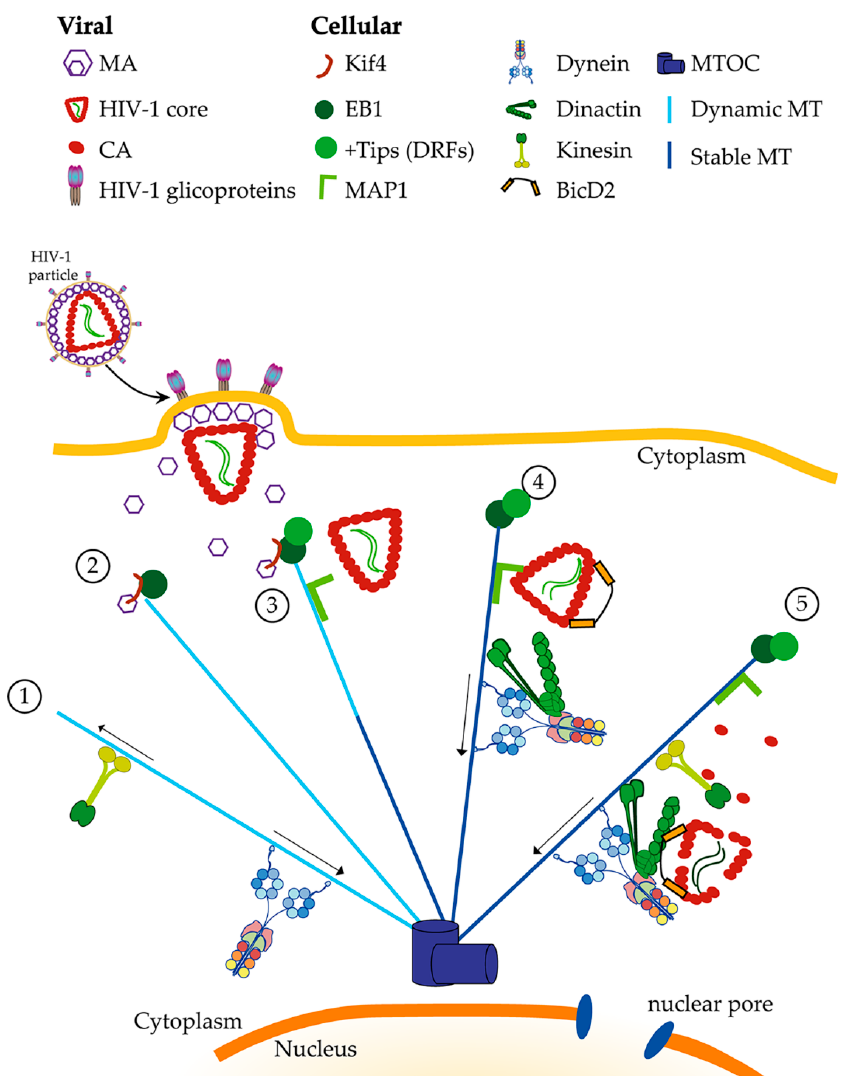
Figure 1. Directed retrograde transport of HIV-1 along microtubules. Directed movement along microtubules is carried out by the ATP-dependent complexes kinesin and dynein, were kinesins are the anterograde motor and dynein is the retrograde motor. This transport can occur along stable and dynamic microtubules. While both kinesin and dynein play crucial roles during retroviral infection, in this figure, we focus on the role of cytoplasmic dynein, leaving kinesins anterograde transport out, as it plays a bigger role during the late stages of the infectious cycle and release of new viral particles ( 1 ). Once a susceptible cell is infected by HIV-1, fusion of the viral and plasma membrane will occur. Then, the viral core and the matrix protein (MA) are released into the cytoplasm, MA by its interaction with Kif4 will recruit the end binding 1 protein (EB1) to the plus end of microtubules ( 2 ). This event will allow the stabilization of microtubules and other +Tip, such as diaphanous-related formins (DRF), can be recruited. Microtubule associated proteins, such as MAP1, can be recruited in an HIV-1-independent manner ( 3 ). HIV-1 core, through the capsid protein (CA), binds to the microtubule stabilization is microtubule-associated protein 1 (MAP1) and Bicaudal D2 (BicD2). It is possible to speculate that MAP1 acts as a hook to attract HIV-1 cores to the microtubules and to the vicinity of dynein ( 4 ). BicD2 acts as the bridge between HIV-1 core and dynein. A functional HIV-1 transport complex is complete once it contains dynein, dynactin and BicD2 together. Then, a directed retrograde movement towards the microtubule organizing center (MTOC) will occur. Along the movement, reverse transcription and uncoating are simultaneously happening ( 5 ). Several cellular factors will help along the way to finally cross the nuclear pore and reach the